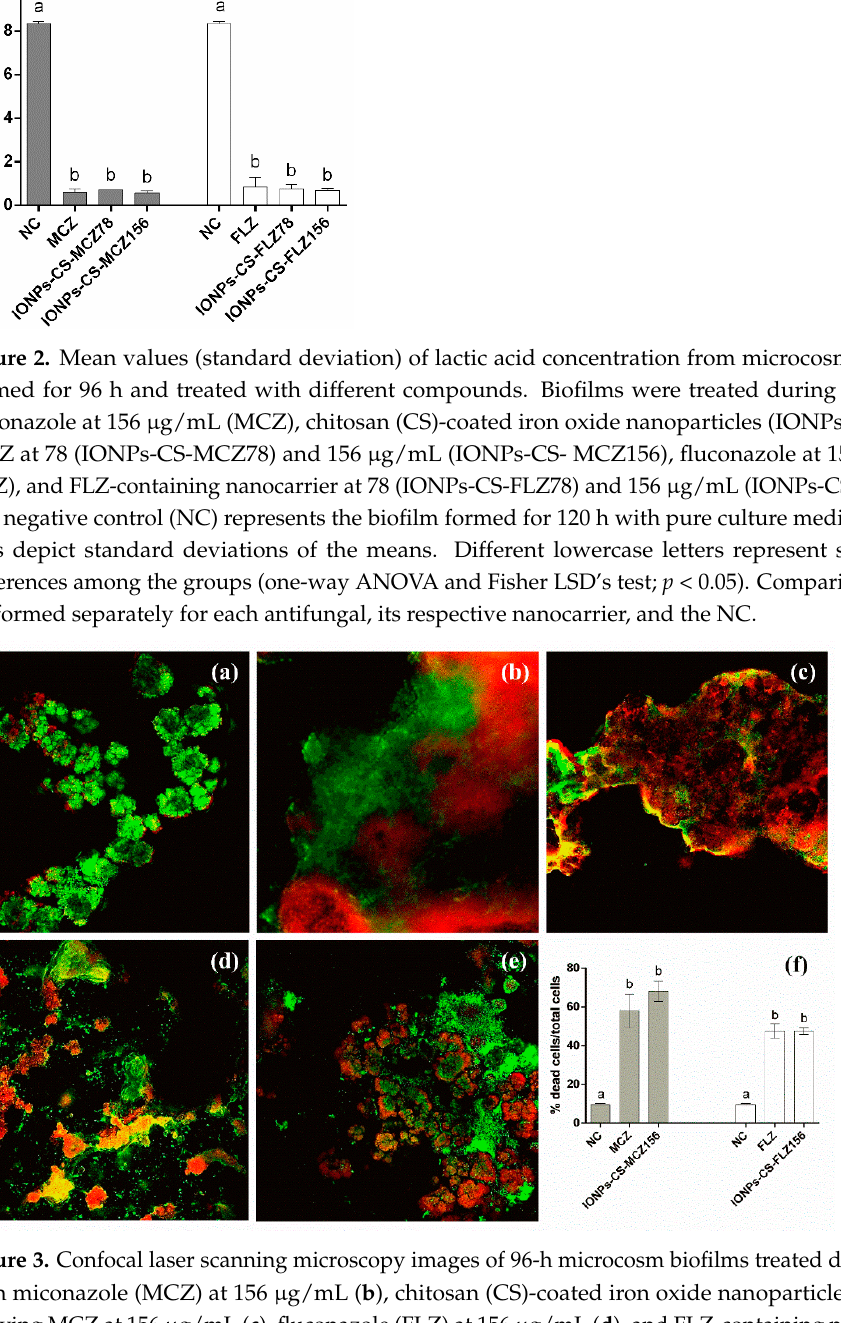
Figure 3. Confocal laser scanning microscopy images of 96-h microcosm biofilms treated during 24 h with miconazole (MCZ) at 156 µg/mL ( b ), chitosan (CS)-coated iron oxide nanoparticles (IONPs) carrying MCZ at 156 µg/mL ( c ), fluconazole (FLZ) at 156 µg/mL ( d ), and FLZ-containing nanocarrier at 156 µg/mL ( e ). The negative control ( a ) represents the biofilm formed for 120 h with pure culture medium. Red and green fluorescence indicate dead and living cells, respectively. Magnification: